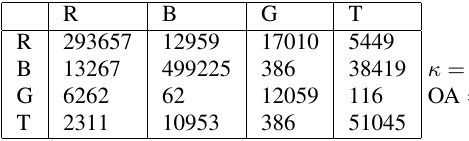
Table 1. Confusion matrix obtained after using NDSM without correction.